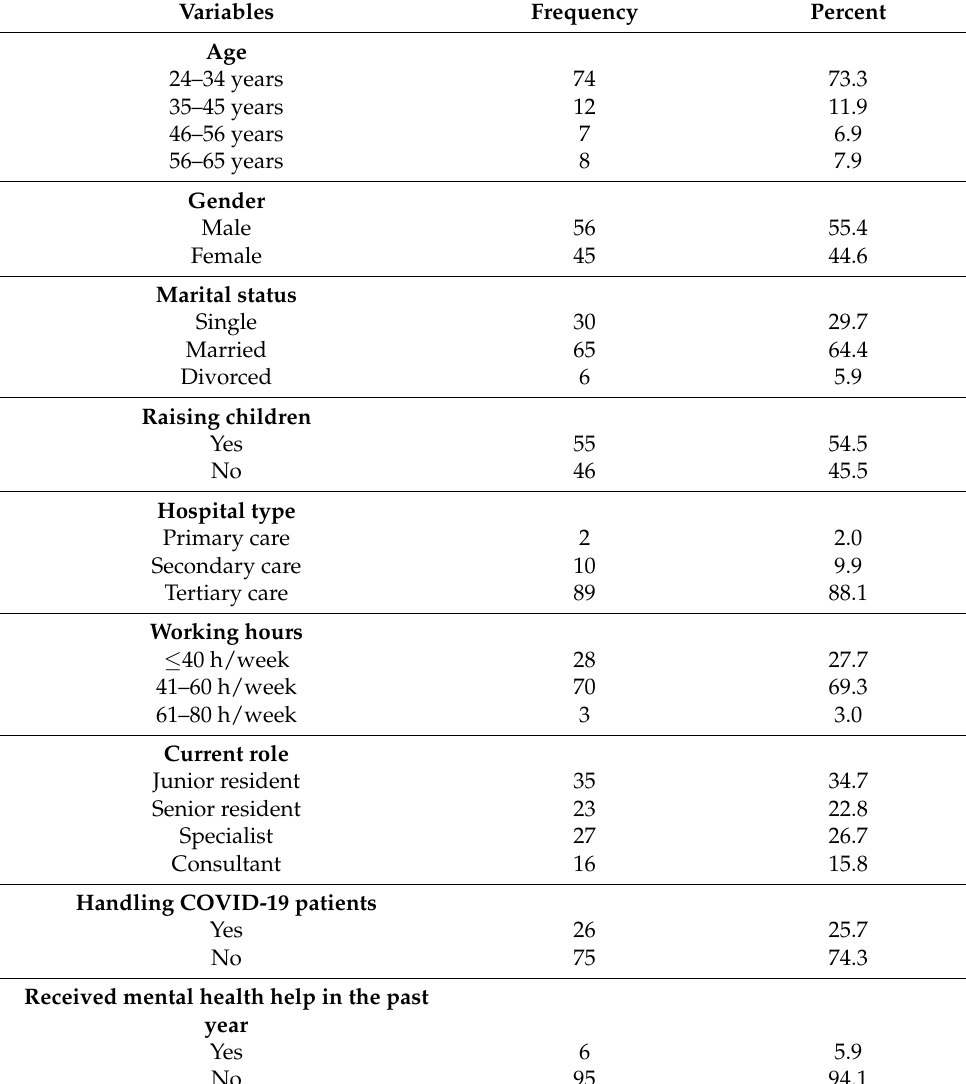
Table 1. Sociodemographic characteristics of the study population.